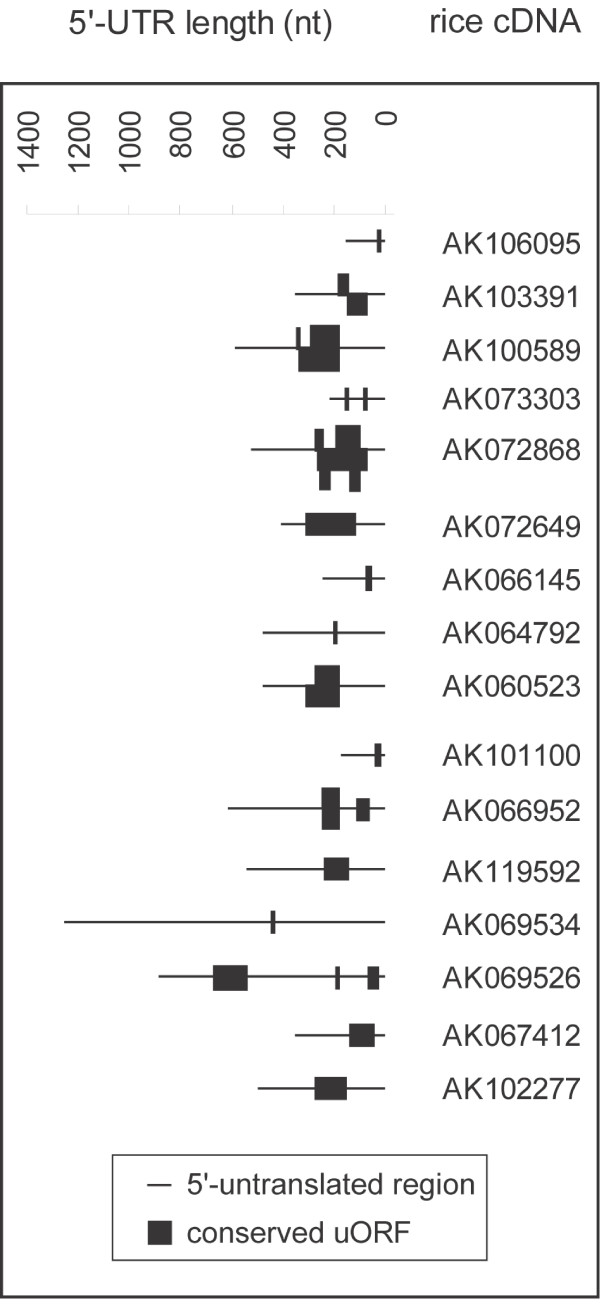
Tran_Figure2.eps. 'The position of conserved uORFs within their 5'-UTRs'. It contains rice uORFs conserved in four other cereals and in Arabidopsis.